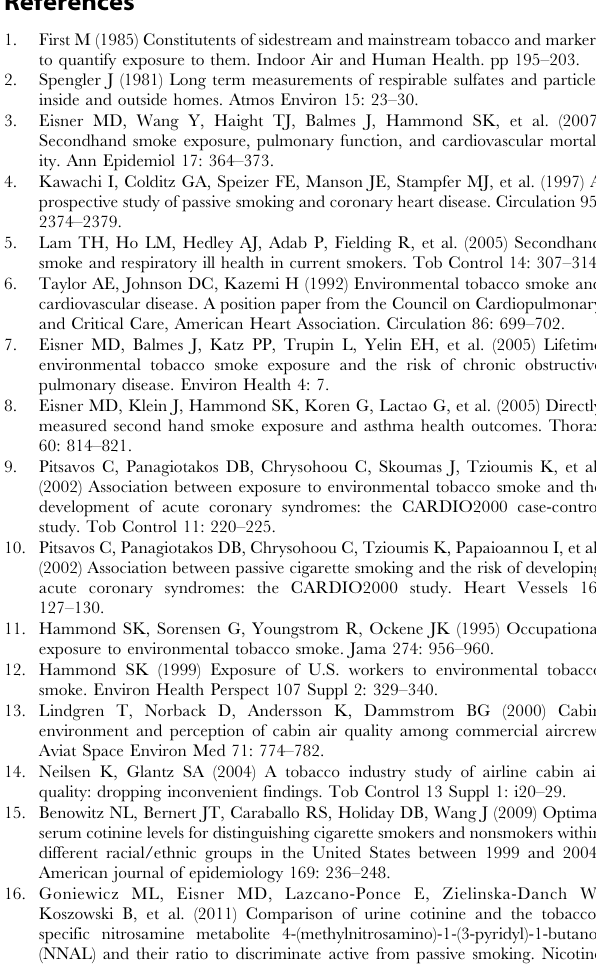
Figure S1 Maximum work, maximum oxygen uptake ( _ VVo 2 ), and maximum ventilatory equivalent of carbon dioxide ( _ VV E / _ VVco 2 ) for never smoking pre-smoking ban flight attendants. Black and white bars represent flight attendants with normal and abnormal resting diffusing capacity, respectively. (TIF) Figure S2 Correlation between single breath carbon monoxide diffusing capacity at rest (sitting position) and within breath diffusing capacity in supine position. (TIF) Table S1 Cardiovascular response to exercise. Data is shown in mean 6 standard deviation. * N= 80; subjects were all female. Abbreviations: SBP: systolic blood pressure; DBP: diastolic blood pressure; _ VVo 2 : Oxygen uptake; AT; anaerobic threshold. (DOC) Table S2 Respiratory response to exercise. Data is shown in mean 6 standard deviation. * N= 80; subjects were all